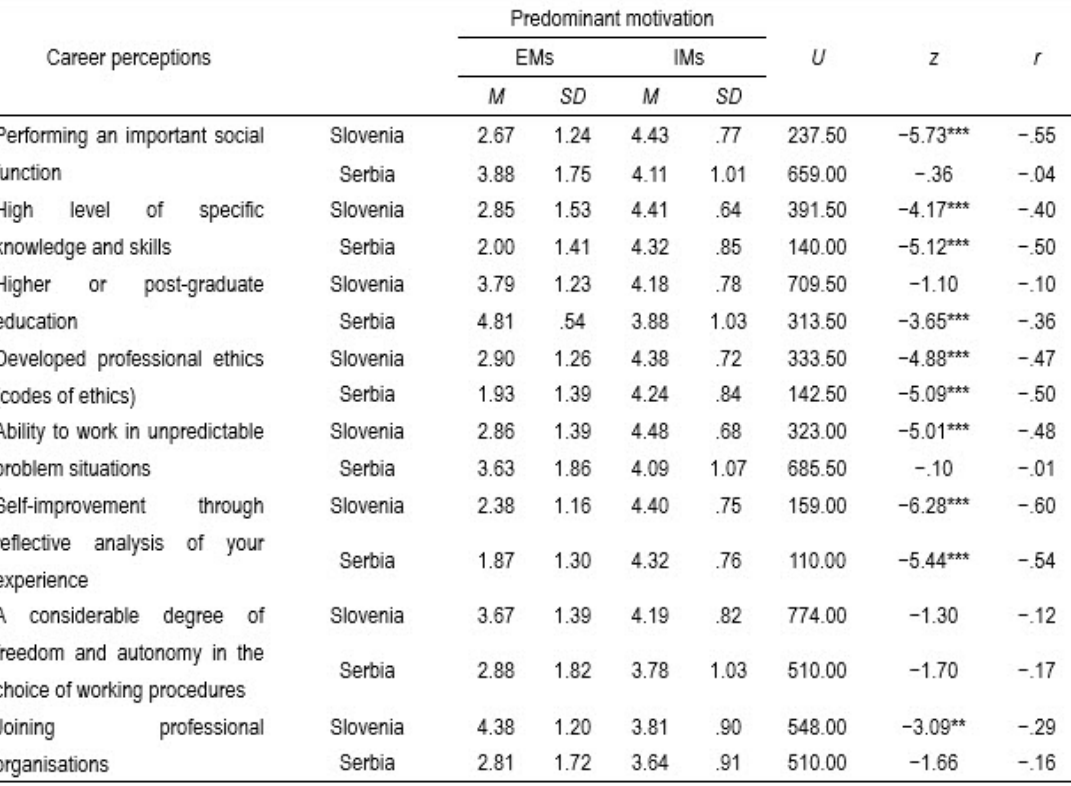
Means, standard deviations, and Mann-Whitney test for individual items of the Career Perceptions